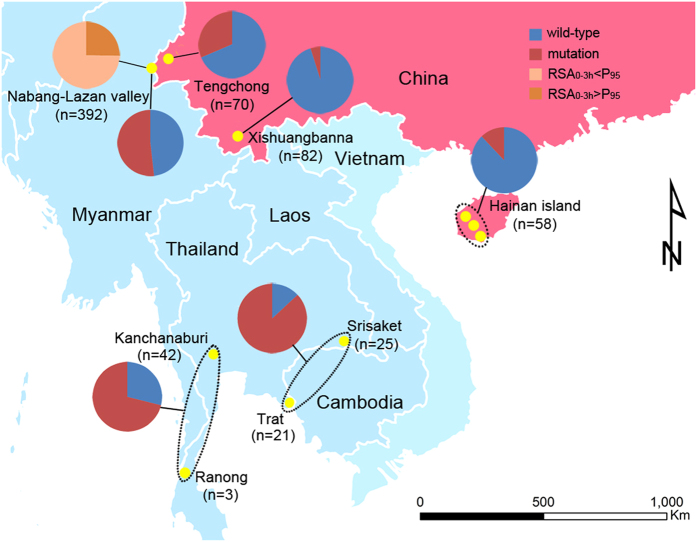
Map showing location of study sites and proportions of isolates with high survival rates and mutations of the K13 gene.The proportions of isolates with parasite survival rates above P95 are indicated in orange and below P95 in pink in the Nabang-Lazan valley. The proportions of wild type isolates are shown in blue and with mutations in the propeller domain of the K13 gene in red. The map was created in ArcGIS 9.3 software (ESRI Inc., Redlands, CA, USA) (http://www.esri.com/).